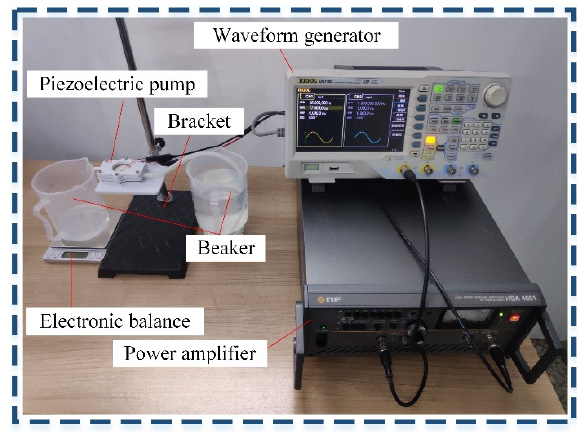
Figure 7. The photograph of the experimental system.